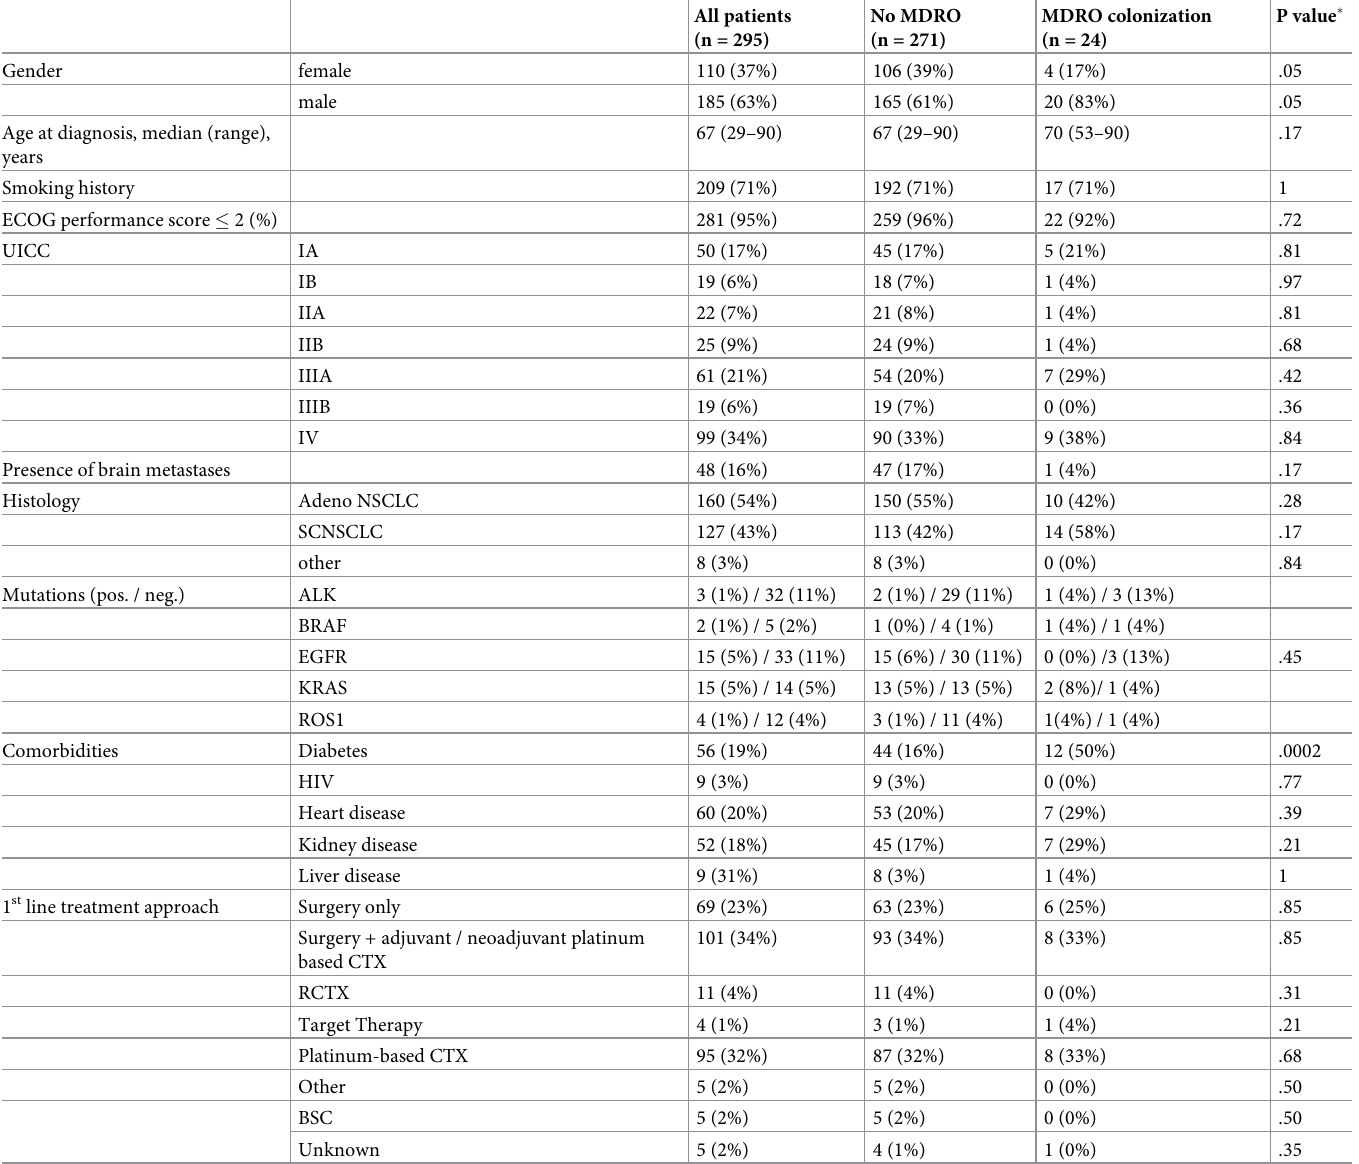
Table 1. Patient and disease